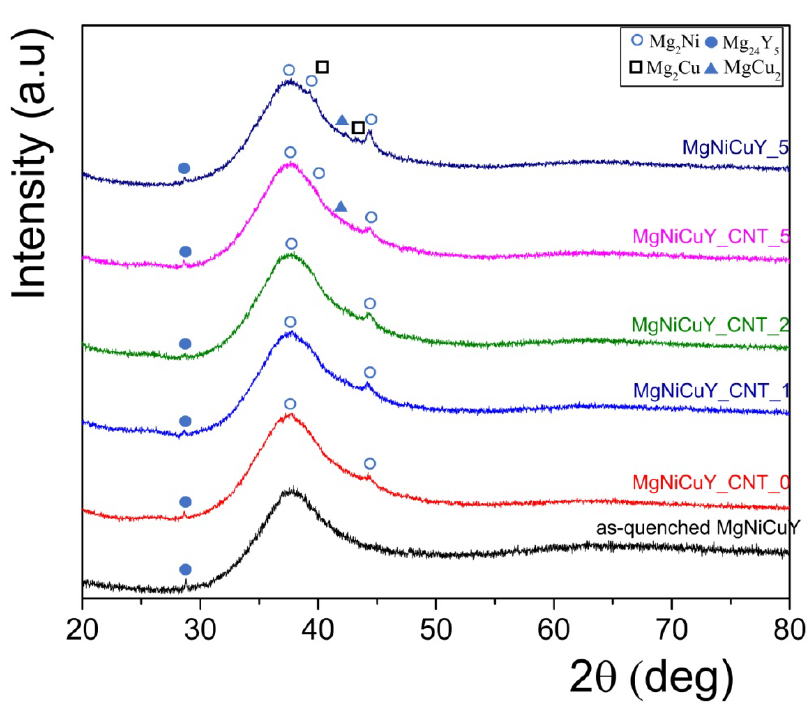
Figure 4. XRD patterns recorded on Mg 65 Ni 20 Cu 5 Y 10 HPT disks and the as-quenched ribbon. In addition to its extreme microstructural stability, the Mg 65 Ni 20 Cu 5 Y 10 glassy alloy also exhibits remarkable thermal stability against severe shear deformation during HPT, as confirmed by Figure 5. It is evident from the figure that the continuous-heating DSC thermograms of the HPT-treated disks are very similar to those of the as-quenched